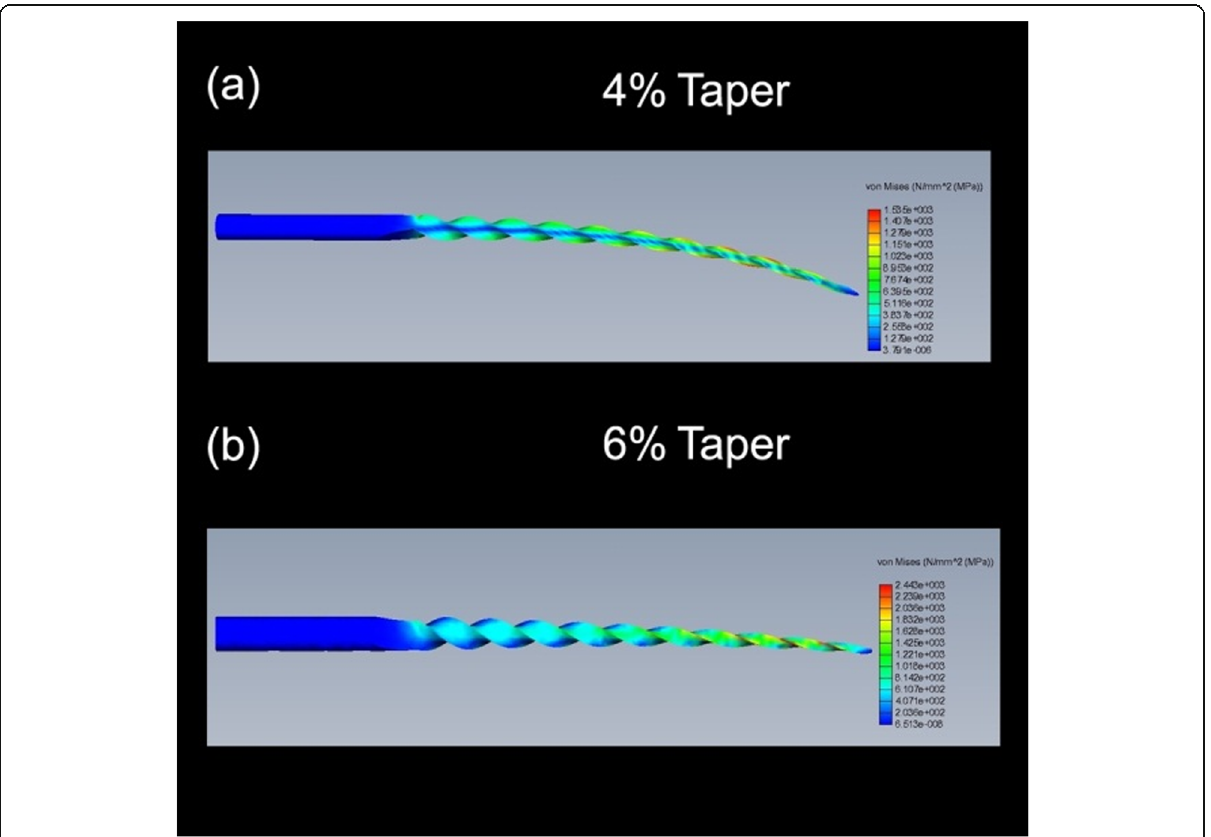
Fig. 7 Stress distribution during bending of different tested file taper. a 4% taper. b 6%